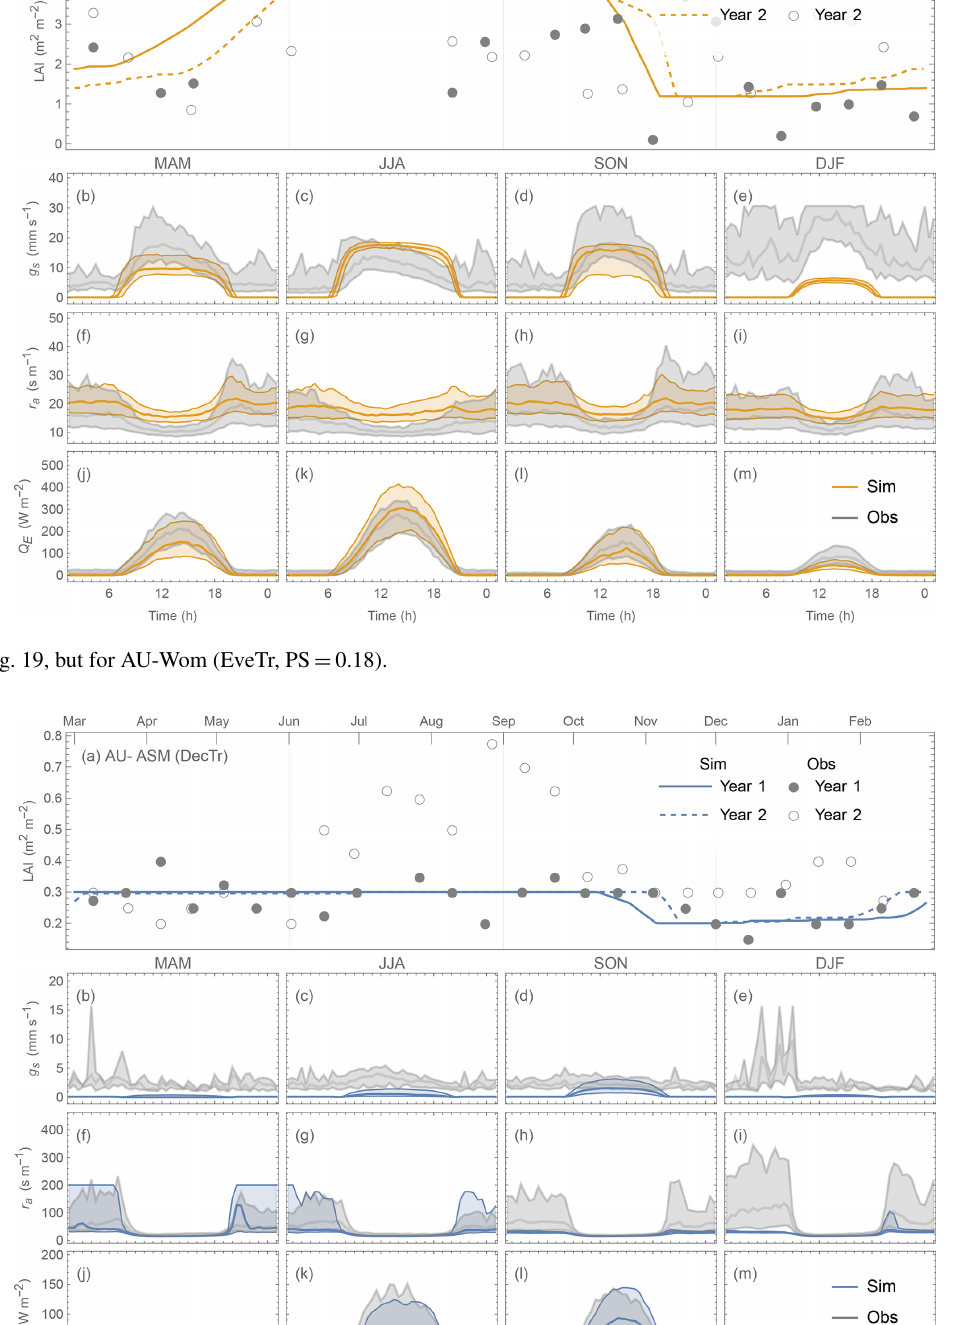
Geosci. Model Dev., 15, 3041–3078, 2022